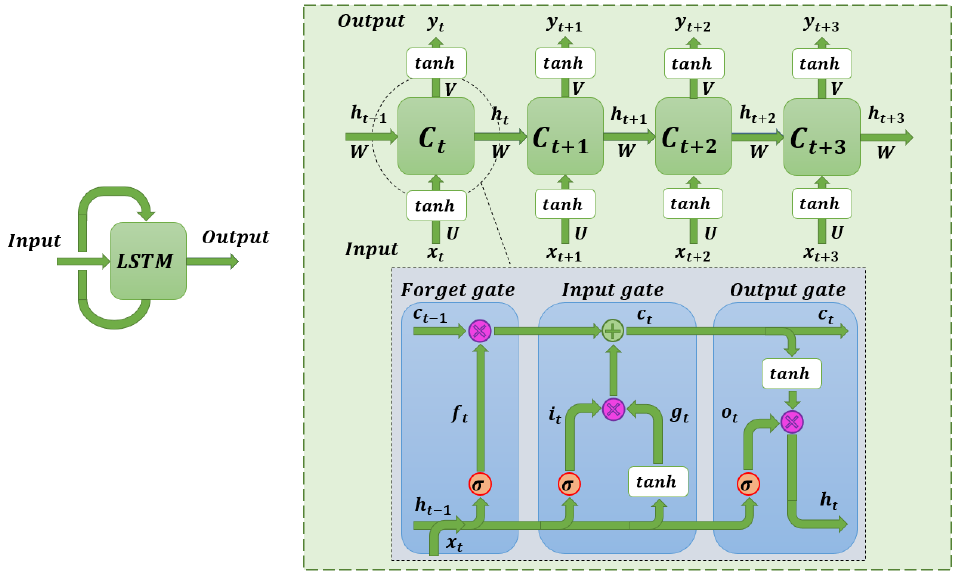
Figure 5. Generic schema of the content of an LSTM neural network